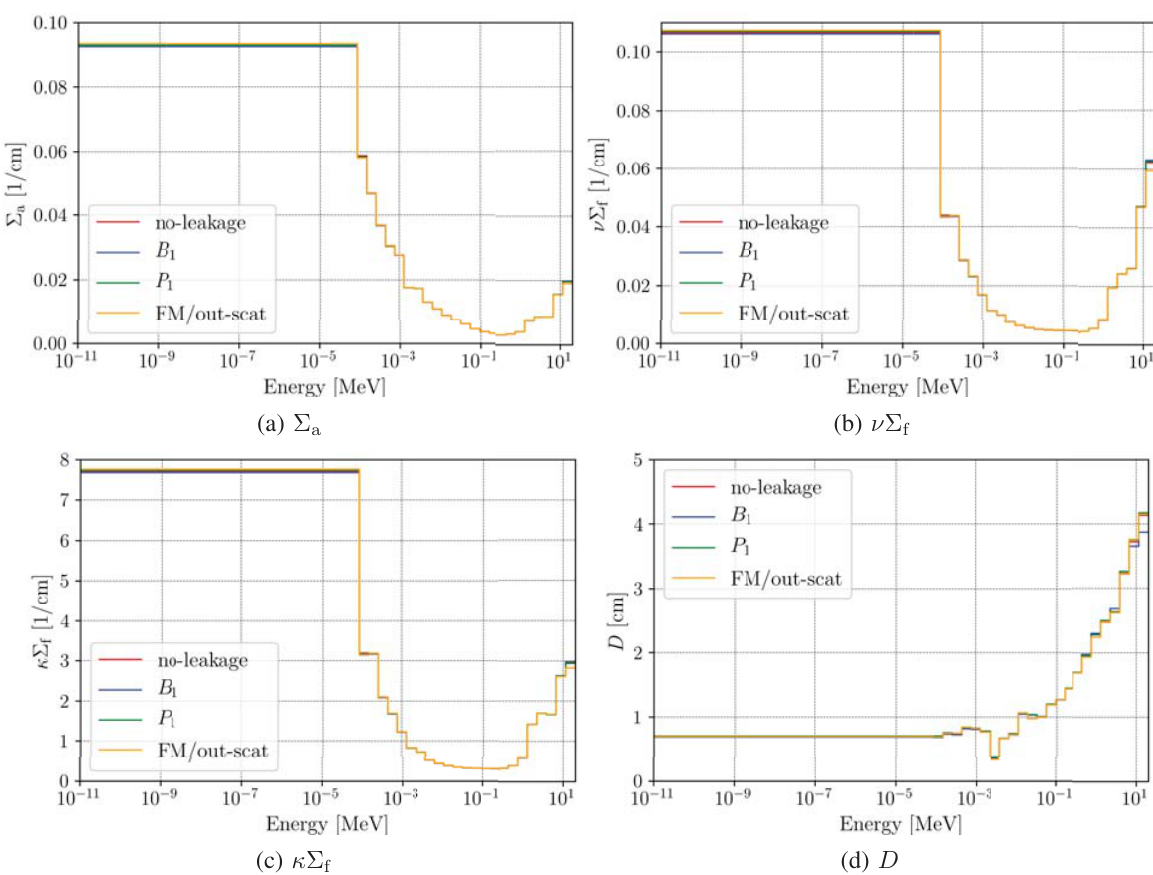
Figure 3: Group Constants in CA Inner Fuel 2D